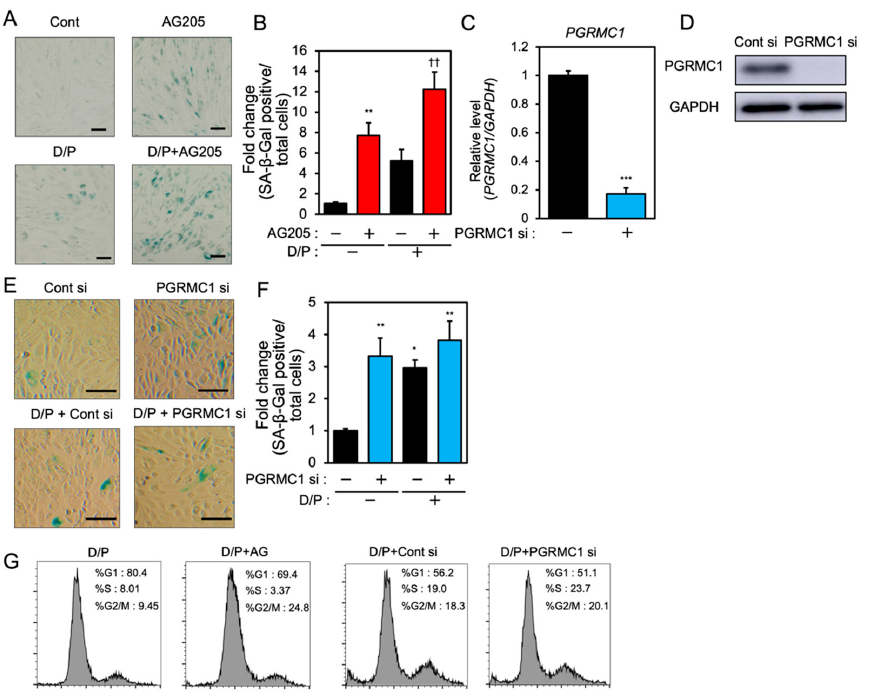
Figure 1. PGRMC1 inhibition and knockdown induce cellular senescence in ESCs. ( A ) ESCs were pre-treated with the PGRMC1 inhibitor AG-205 (10 μ M) for 1 h and then stimulated with db-cAMP (500 μ M) and P4 (1 μ M) (D/P) for 2 days. The ESCs were stained for SA- β -Gal. ( B ) The graph shows the relative fold change in SA- β -Gal-positive cells. Red bars show the AG205-treated group. Values represent mean ± SEM from three independent experiments with different ESCs. ** p < 0.01 vs. con- trol. †† p < 0.01 vs. D/P. ( C ) ESCs were transfected with a control or PGRMC1 siRNA for 1 day and treated with D/P for 2 days. The PGRMC1 mRNA expression was evaluated by real-time RT-PCR. Blue bar shows the PGRMC1 siRNA-transfected group. *** p < 0.001 vs. control. ( D ) The PGRMC1 protein level was evaluated by immunoblotting. ( E ) Cells were stained for SA- β -Gal. ( F ) The graph shows the relative fold change in SA- β -Gal-positive cells. Values represent mean ± SEM from three independent experiments. Blue bars show the PGRMC1 siRNA-transfected group. * p < 0.05, ** p < 0.01 vs. control. The bar in the figure ( A , E ) represents 100 μ m. ( G ) ESCs treated with AG205 or PGRMC1 siRNA were stimulated with D/P for 2 days and analyzed by flow cytometry. 3.2. PGRMC1 Inhibition and Knockdown Alter the Expression of Senescence-Associated Inflammatory Factors in ESCs We next evaluated the effects of PGRMC1 inhibition and silencing on the expression of senescence-associated inflammatory factors in ESCs. Although IL8 mRNA was down- regulated in the D/P-stimulated decidualizing cells (Figure 2A), the IL8 secretion was in- creased by D/P treatment (Figure 2B). Treatment with AG-205 further increased IL8 secre- tion in the D/P-treated cells (Figure 2B). In contrast, PGRMC1 siRNA decreased IL8 secre- tion in the D/P-stimulated cells (Figure 2B). IL6 expression was suppressed in the D/P-stimulated ESCs (Figure 2C). AG205 in- creased mRNA expression and the secretion of IL6 in the presence of D/P. However, PGRMC1 knockdown did not alter IL6 mRNA expression and the secretion under D/P stimulation (Figure 2C,D). Decidualization increases the secretion of IL15. Treatment with the PGRMC1 inhibitor or siRNA did not alter the mRNA expression of IL15 in the absence of the decidual stimulus. Treatment with AG-205 plus D/P reduced IL15 expression com- pared with the D/P treatment only. PGRMC1 siRNA increased the expression of IL15 in decidualized cells in the presence of D/P (Figure 2E).